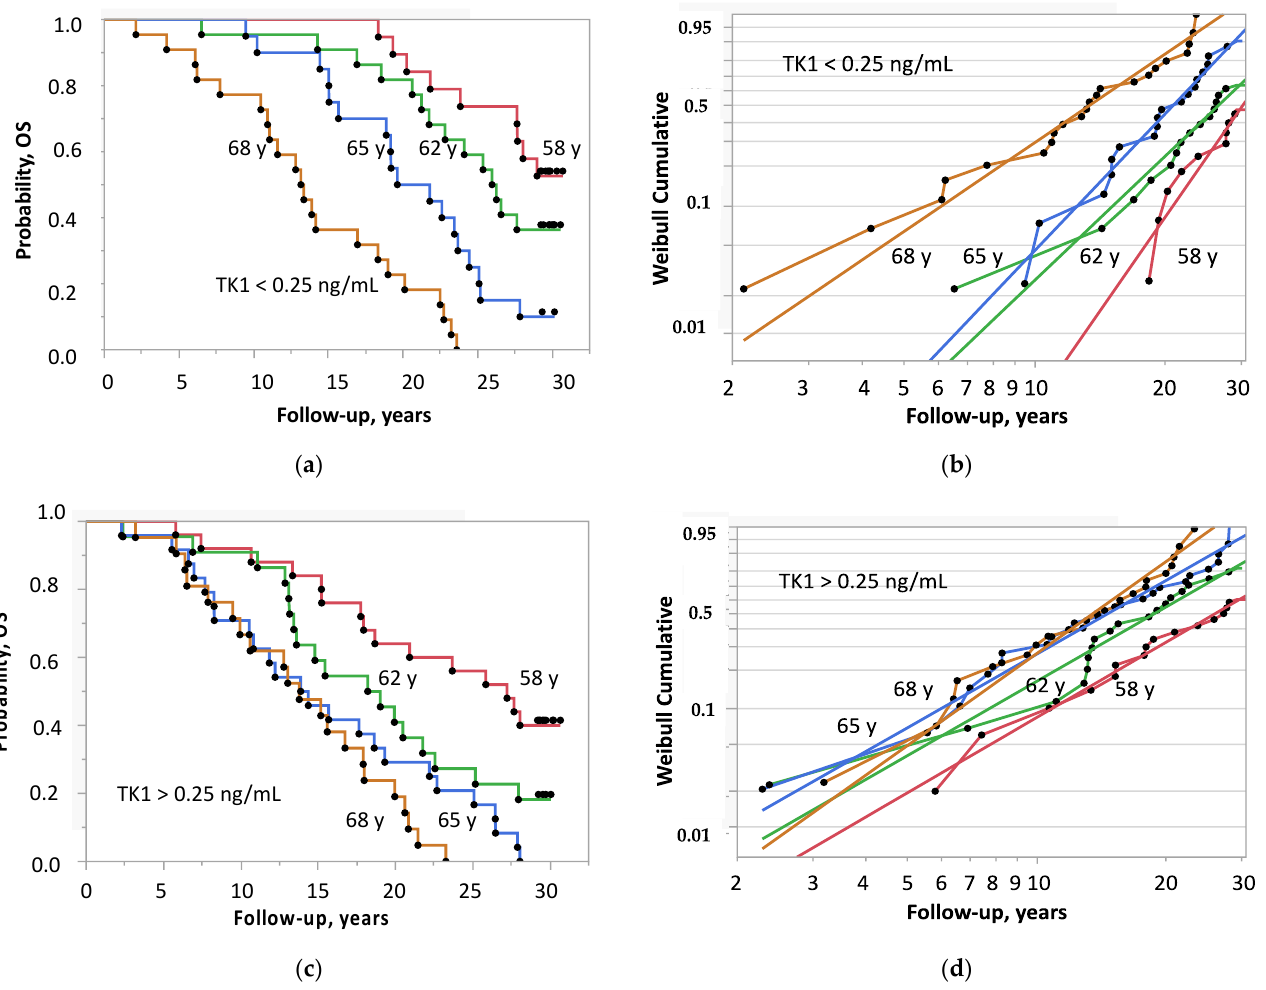
Figure 4. Overall survival of 175 men with prostate cancer stratified by quartiles of age at screening and median TK1 concentration: ( a ) Kaplan – Meier estimates of TK1 concentrations <0.25 ng/ml; ( b ) Weibull-transformed Kaplan – Meier estimates of TK1 concentrations <0.25 ng/ml; ( c ) Kaplan – Meier estimates of TK1 concentrations >0.25 ng/ml; ( d ) Weibull-transformed Kaplan – Meier estimates of TK1 concentrations >0.25 ng/ml.